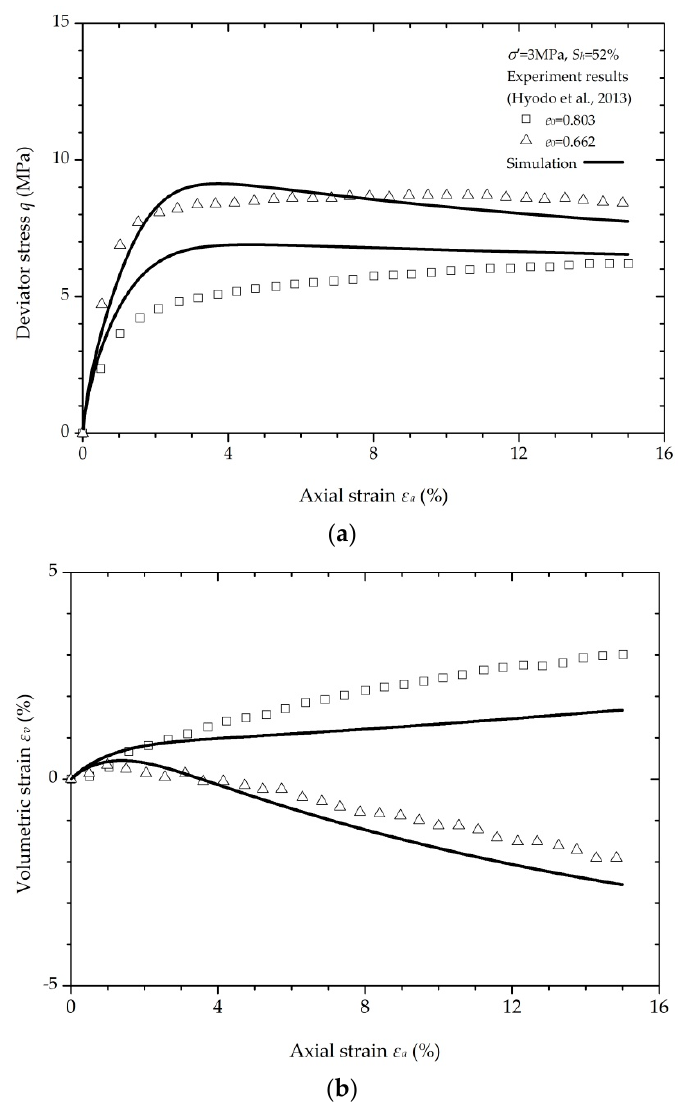
Figure 6. Comparison between the drained triaxial test results and the model predictions for MHBS compacted to different initial void ratios: ( a ) relationship between deviator stress q and axial strain ε a ; ( b ) relationship between volumetric strain ε v and axial strain ε a .